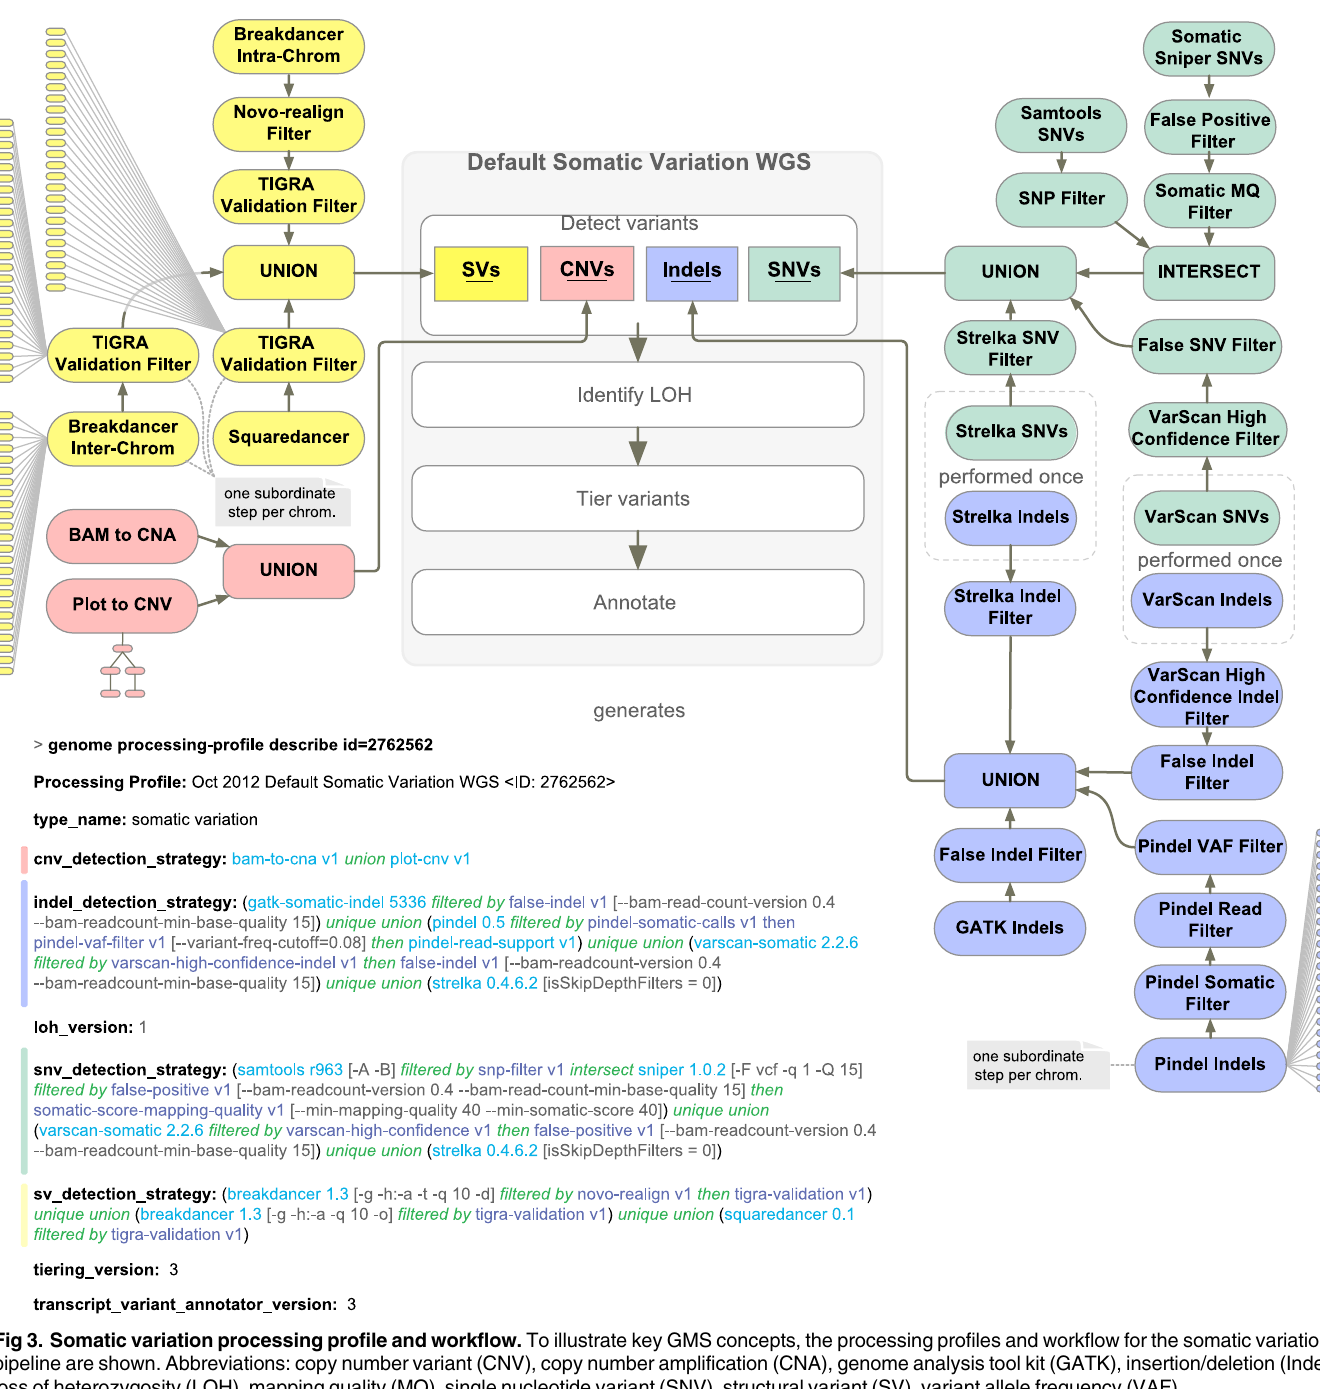
PLOS Computational Biology | DOI:10.1371/journal.pcbi.1004274 July 9,